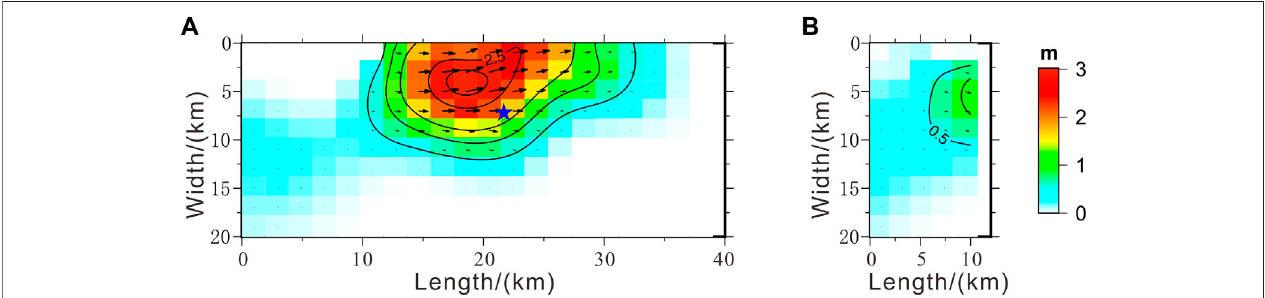
FIGURE6| FaultslipdistributionoftheMenyuanMs6.9earthquake. (A,B) aretheslipdistributionsofthemainfaultandtheminorbranchfaultalongthefaultstrike, respectively;blackarrowsrepresenttheslipvector,anditsdirectionrepresentsthemovementdirectionofthehangingwallrelativetothefootwall;thebluestarindicates the location of the mainshock determined by Yang et al. (2022).